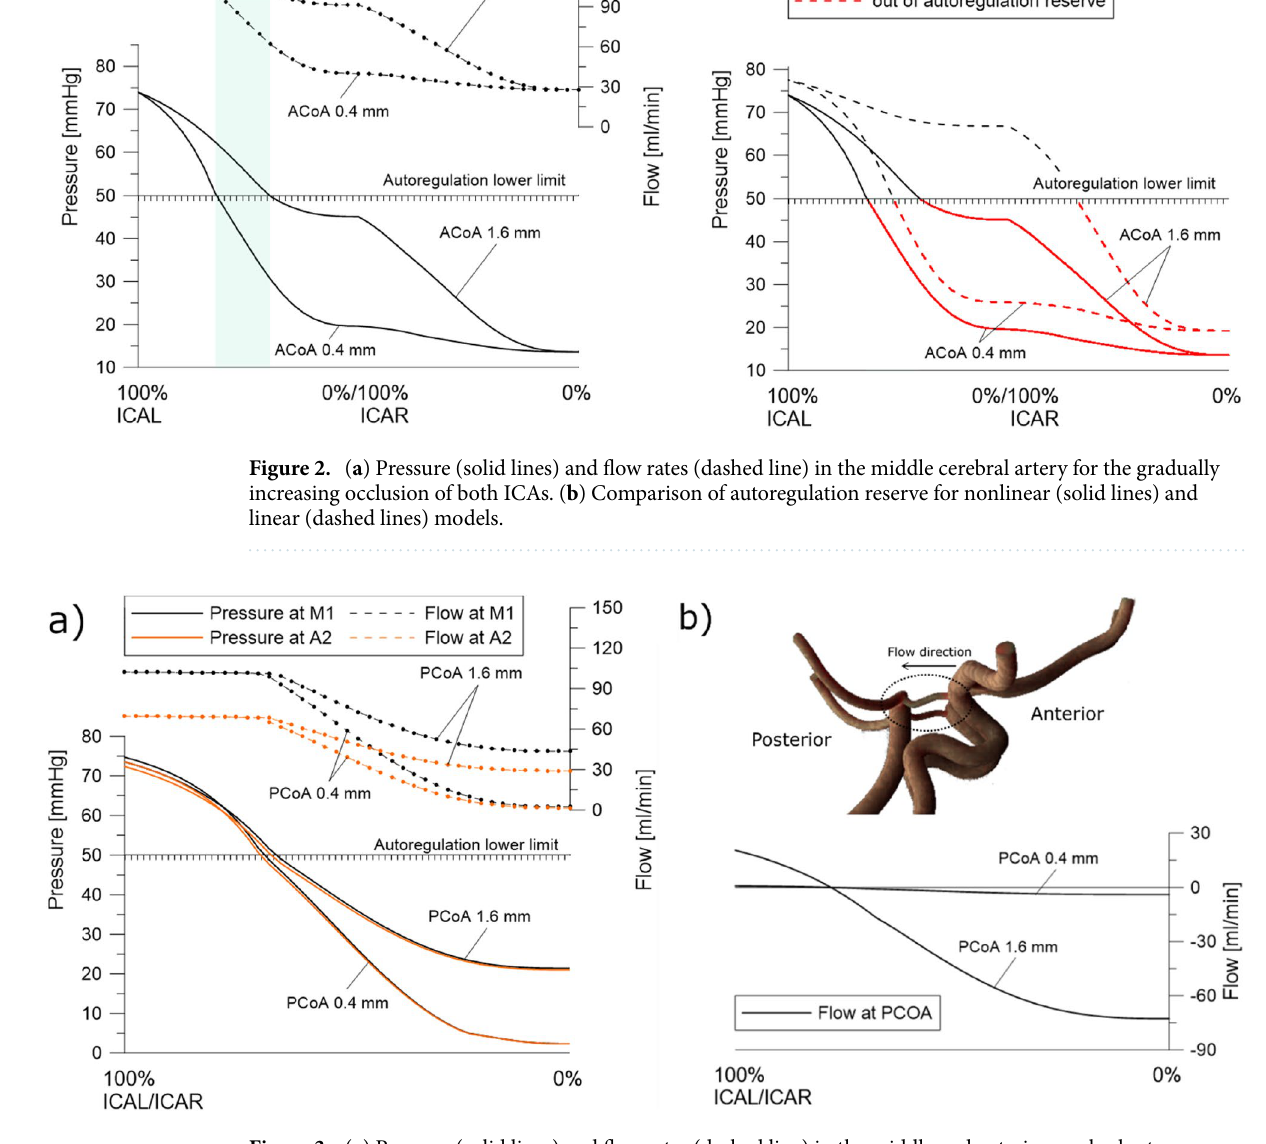
Figure 3. ( a ) Pressure (solid lines) and flow rates (dashed line) in the middle and anterior cerebral artery for concurrent occlusion of both ICAs. ( b ) Flow rates in the posterior communicating arteries during the concurrent occlusion of both ICAs. A flow direction denoting positive flow rates was schematically shown using an